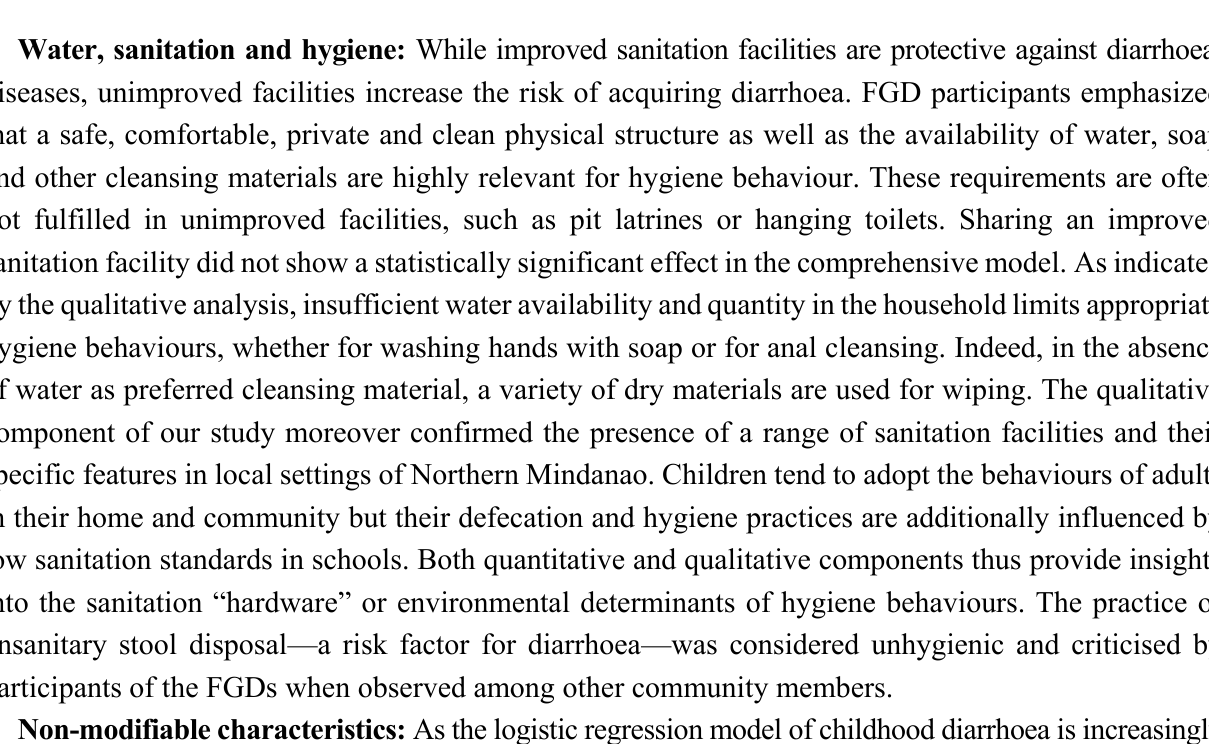
Figure 4. Summary of Key